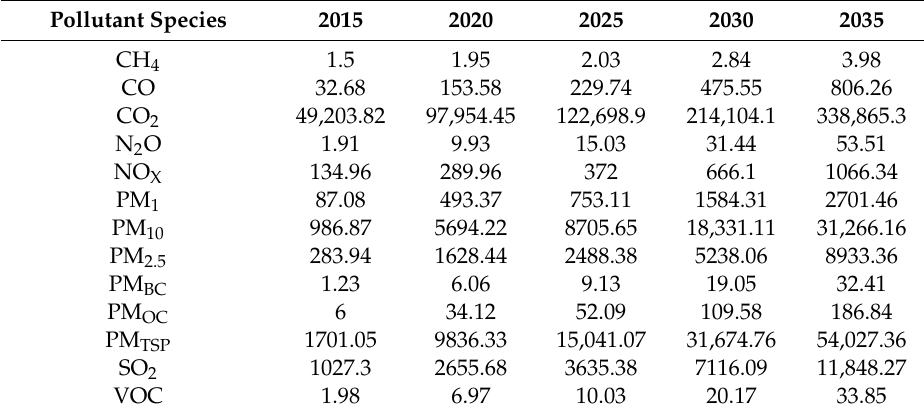
Table 4. Air pollutants emissions in the Coal-40 scenario